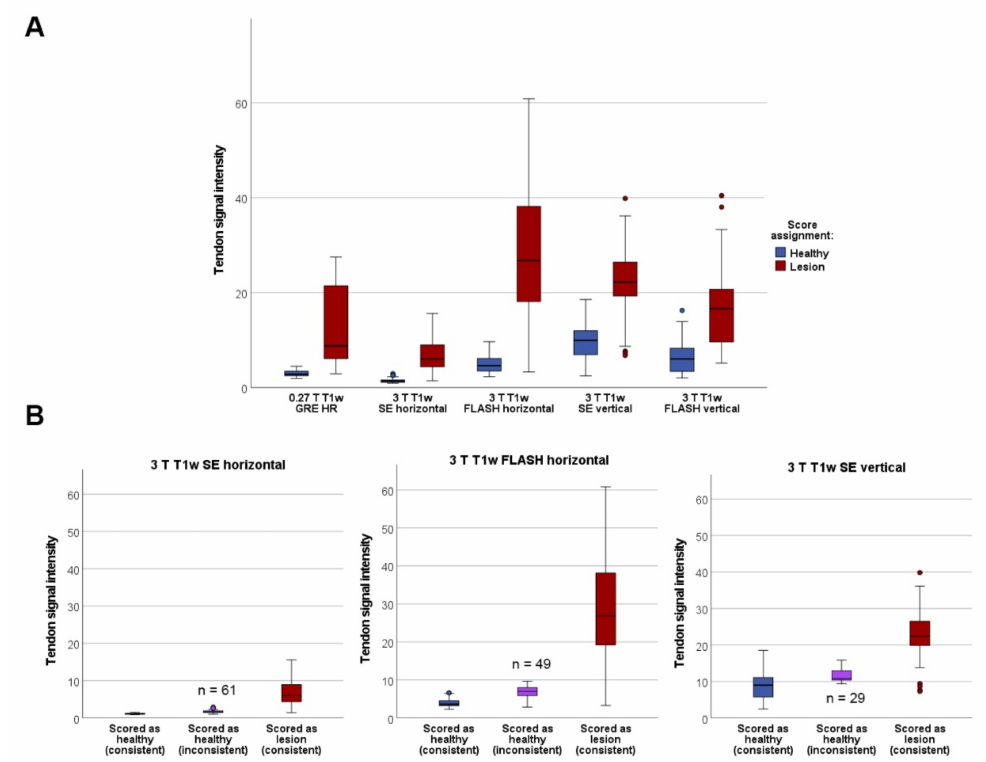
Figure 2. Tendon signal intensities by score assignment. ( A ) Tendon signal intensities in MRI images scored as affected with a lesion were significantly higher than in images scored as healthy, with p < 0.001 for all T1w sequences. However, more overlap between groups and more outliers were present in the high-field sequences. ( B ) In the high-field (3 T) T1w SE and FLASH sequences in horizontal position as well as in the SE sequence in vertical position, the score assignment was not consistent with the more reliable low-field (0.27 T) score in the indicated numbers of images. These were scored as healthy in the respective high-field T1w sequences, although a lesion was visible in the low-field T1w GRE sequence. Tendon signal intensity in these inconsistently scored images was as low or nearly as low as in the images that were scored as healthy across all T1w sequences. Data were obtained from n = 195 matched